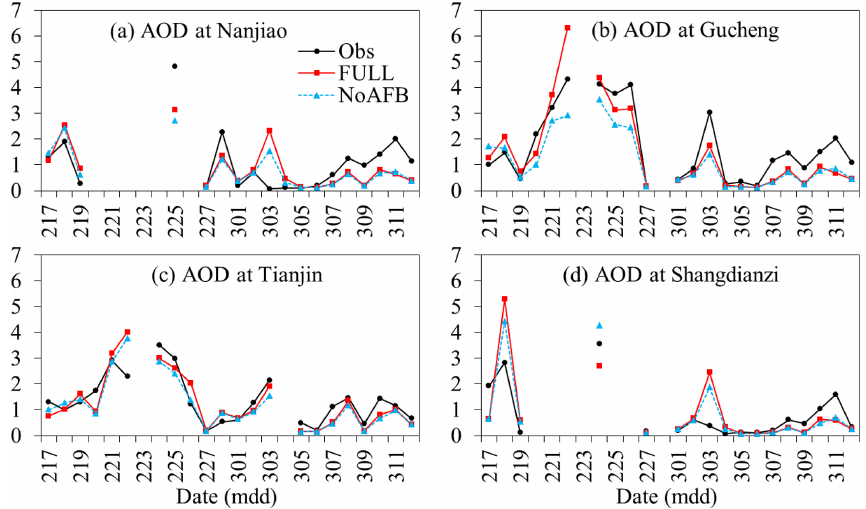
Figure 5. The model-simulated and observed daily-mean AOD (at 550nm) at the four sites of CARSNET. Table 3. Performance statistics for daily-mean AOD at the four CARSNET sites in the BTH region. Mean observation (Obs), mean simulation (Sim), correlation coefficient ( R ), and normalized mean bias (NMB, in %) are listed. FULL NoAFB Sites Samples